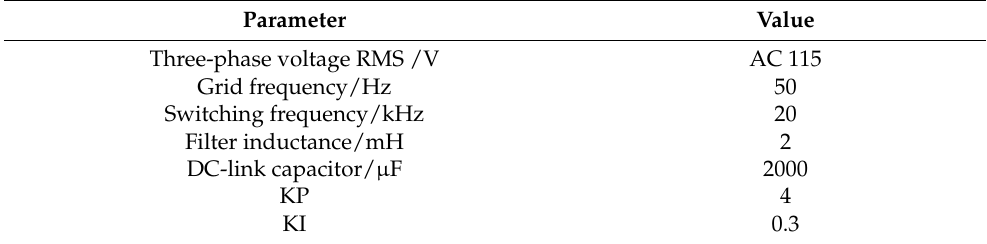
Table 4. Key parameters of the simulation.